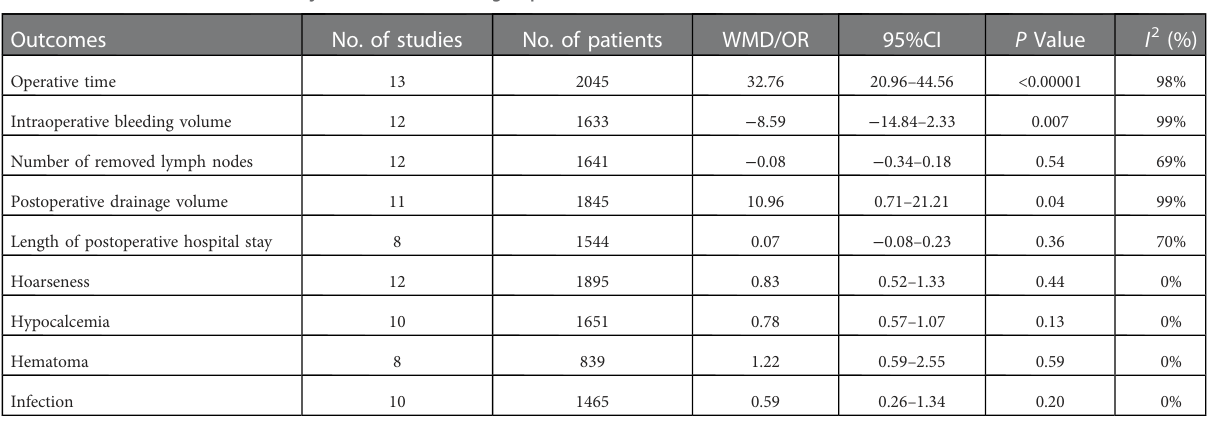
WMD, weighted mean difference; CI, con fi dence interval; OR, Odds